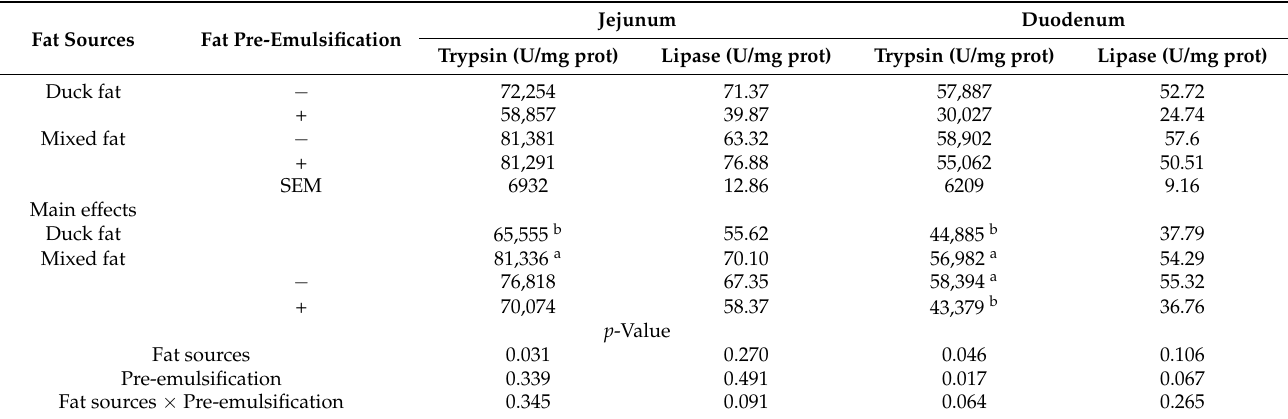
Table 5. Effects of fat sources and pre-emulsification on the activity of trypsin and lipase in jejunum as well as in duodenum of ducks at 34 days of age 1